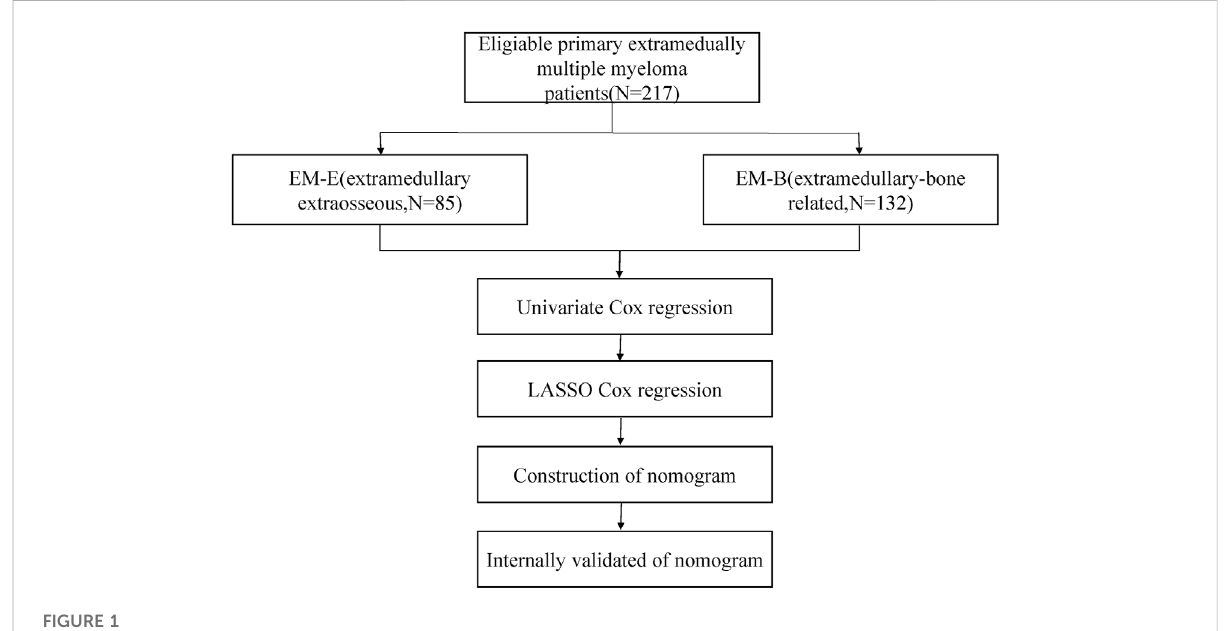
FIGURE 1 Flow chart of this